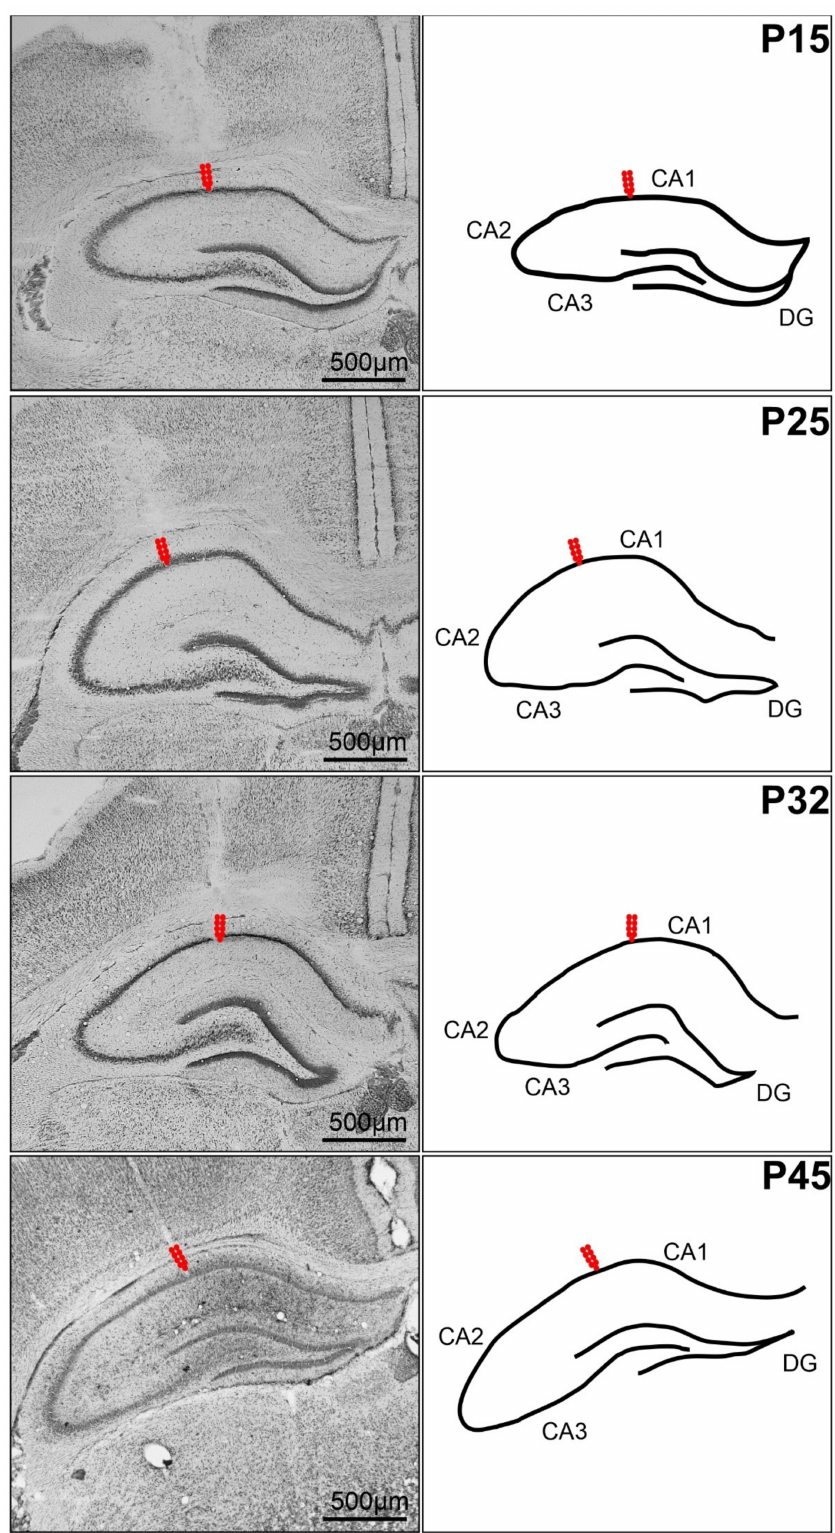
Figure 5. Coronal sections of rat hippocampus after electrical stimulation of the CA1 regions. From left to right: in Nissl-stained sections and in schematic imagery. From top to bottom: 15, 25, 32, and 45-day-old rats. Arrows show the location of the registration electrodes. For scalebar, see